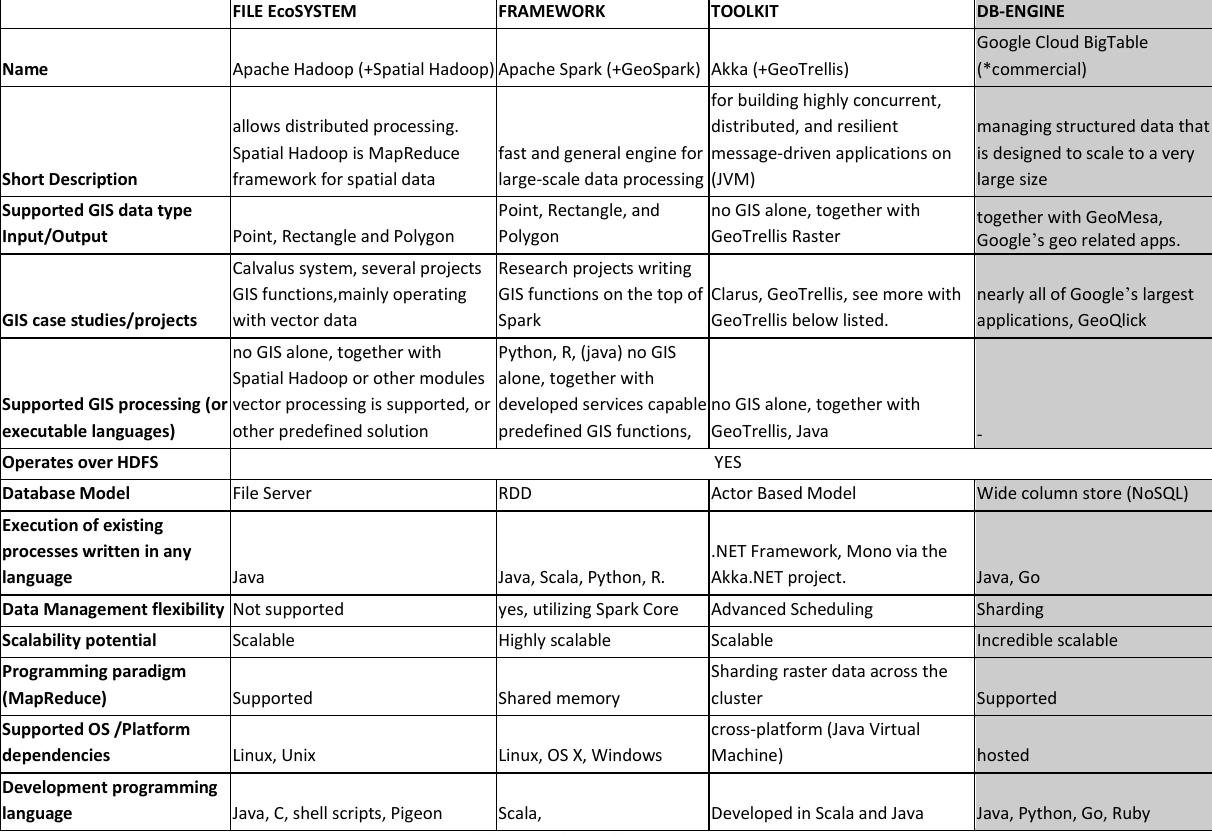
Table 2. Technical comparison